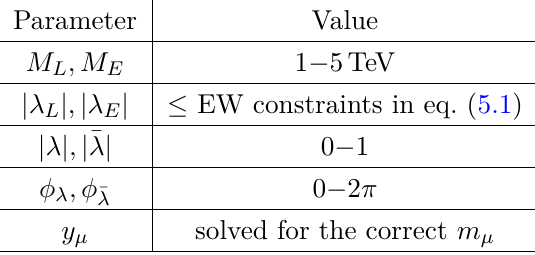
Table 2 . Ranges of parameters randomly chosen for the sampling points. Around 4 × 10 5 sampling points for the results are shown in the scattering plots.